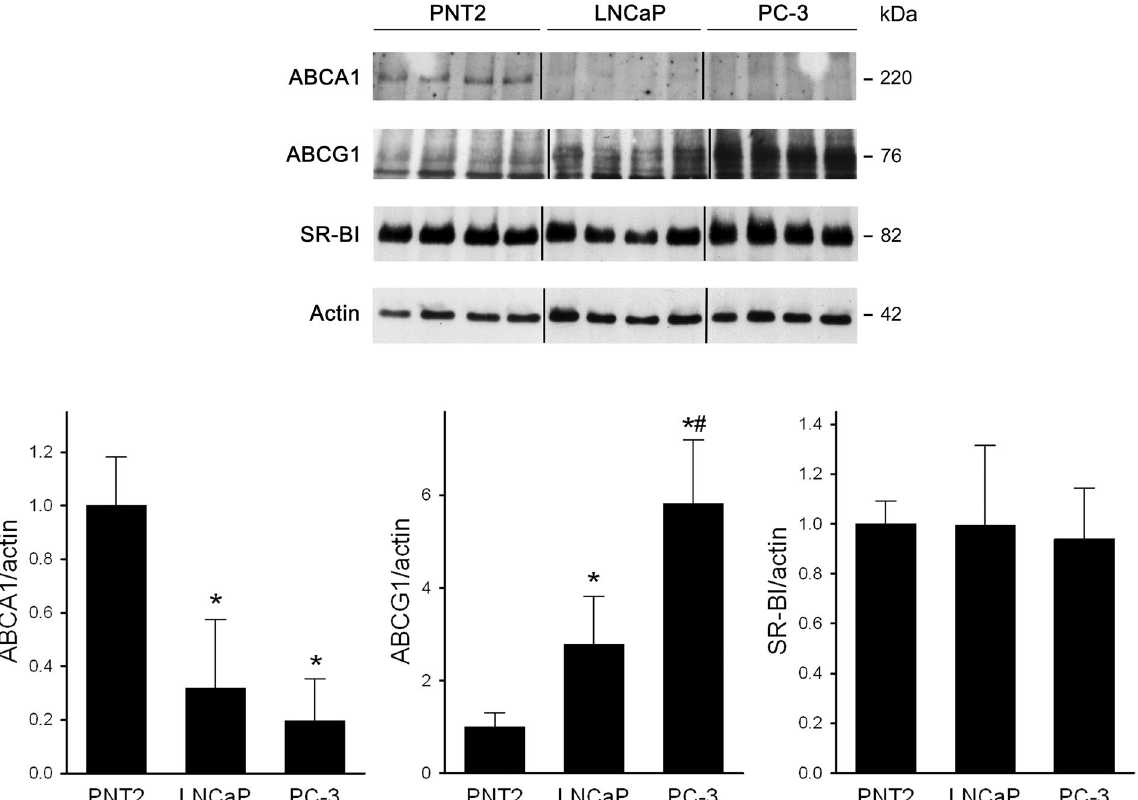
Figure 3. Expression of ABCA1, ABCG1 and SR-BI in prostate cell lines. Protein expression was analyzed by western blotting in PNT2, LNCaP and PC-3 cell lines. Results of the densitometric analysis are expressed as fold increase of the target/ β -actin ratio in tumour cell lines vs PNT2 cells, mean ± SD, n = 7. Representative blots are shown at the top. Images have been manipulated to change the original loading sequence LNCaP-PNT2-PC3 into the more appropriate PNT2-LNCaP-PC3. Images are from the same blots and same exposures. * P < 0.05 vs PNT2, # P < 0.05 vs